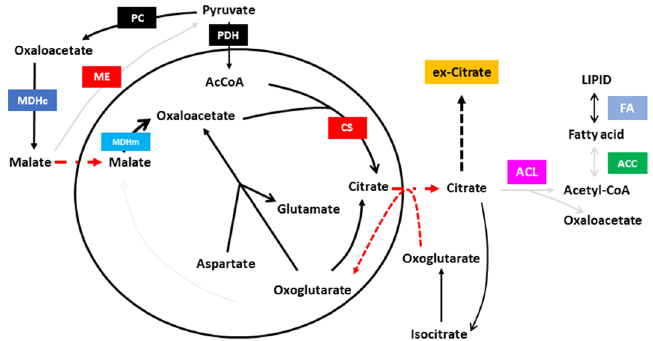
Figure 5. Illustrated balance of citrate overflow. Oxoglutarate and aspartate, malate and pyruvate mainly contribute to mitochondrial citrate overflow. ATP citrate lyase (ACL) inactivation allows cytosolic citrate accumulation and citrate production. Fluxes to lipogenesis is globally limited. Fatty acid accumulation from lipolysis is predicted to trigger ROS accumulation.